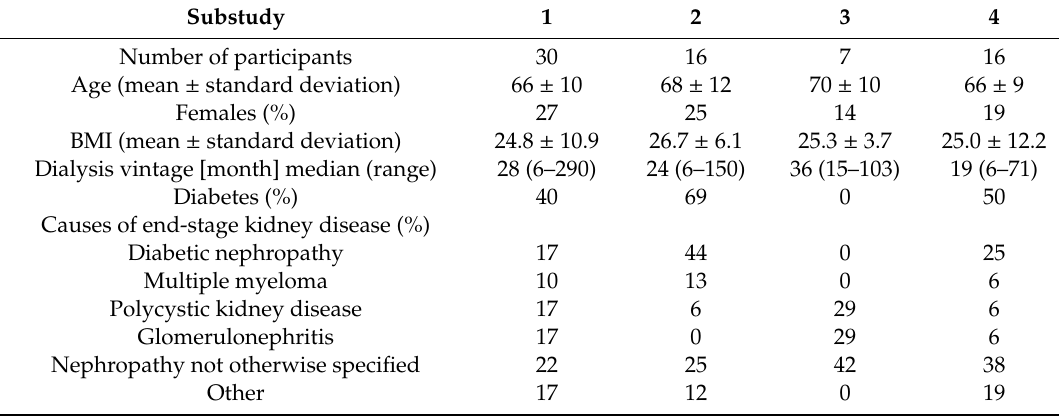
Table 2. Vitamin K intake in patients on haemodialysis based on a Food Frequency Questionnaire (FFQ).